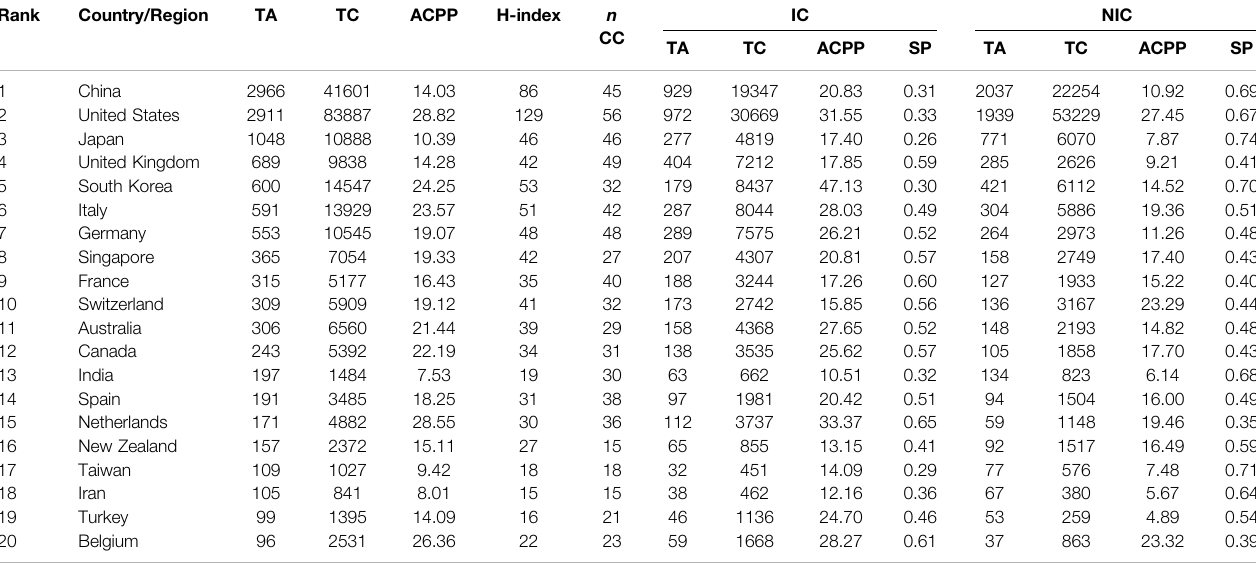
TABLE 1 | The top 20 most productive countries/regions in soft robotics fi eld during 2010 – 2021. Rank Country/Region